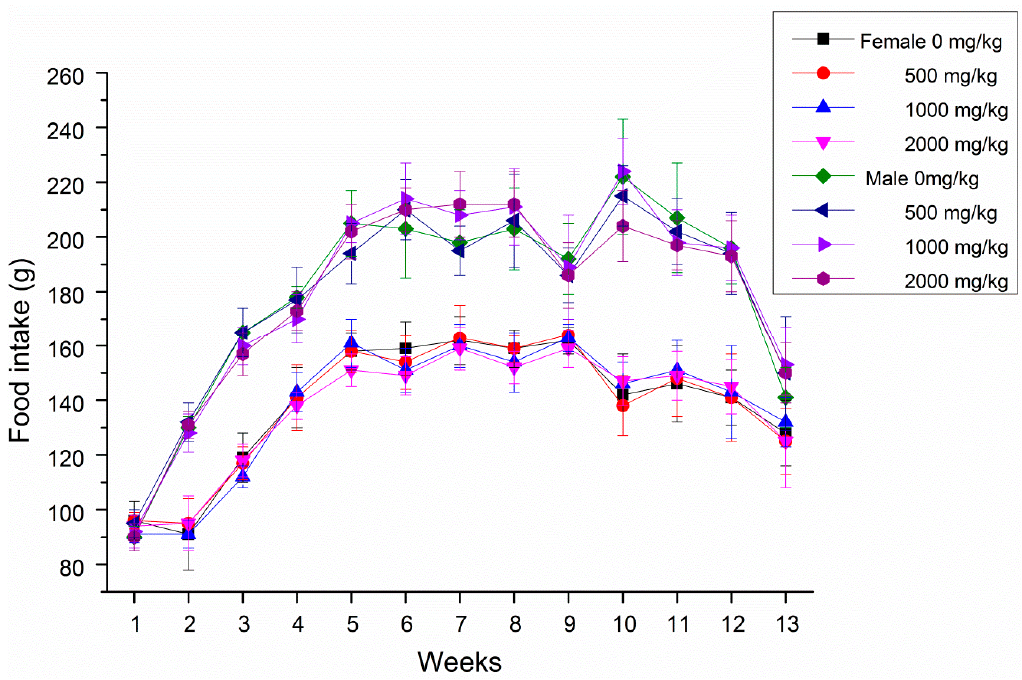
Figure 4. Food intake of female and male rats treated with GBP per week for 91 day.